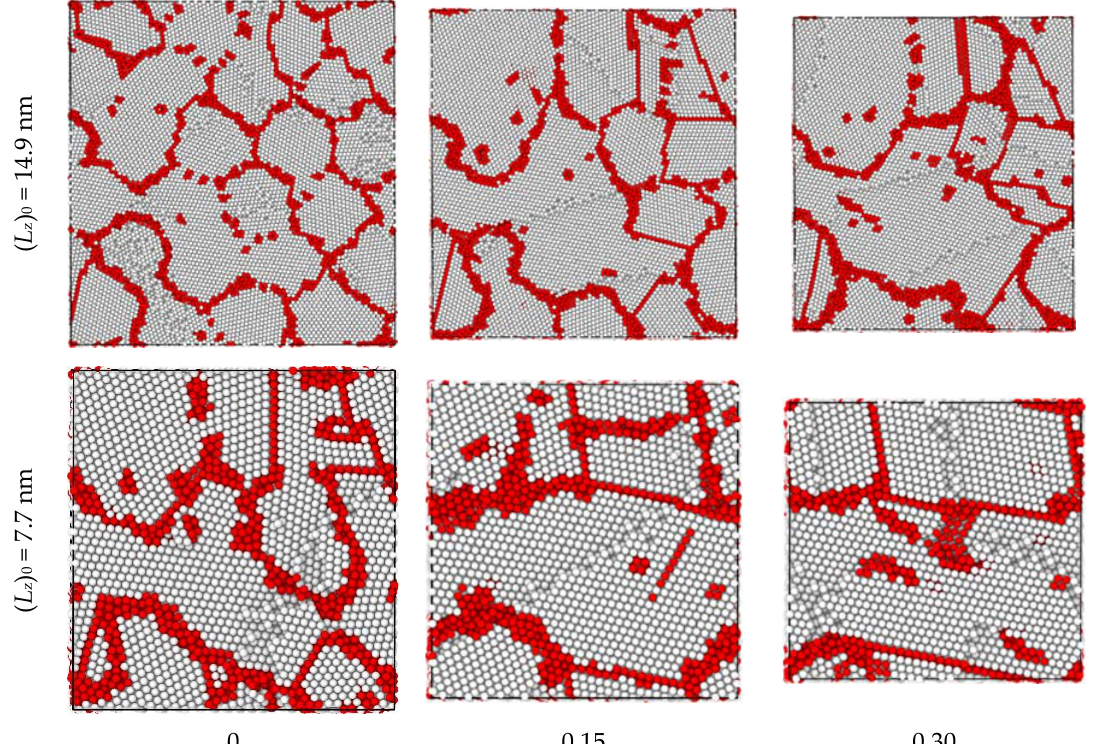
Figure 5. Sections of samples of initial length 30.3, 14.9 and 7.7 nm at three deformation levels. Main structural changes (dissolution of subgrain boundaries, wall annihilation by GB migration shear-coupled tilt GB migration (SCM) and increased presence of low-energy twin boundaries by grain rotation) occur for deformations smaller than 0.15.